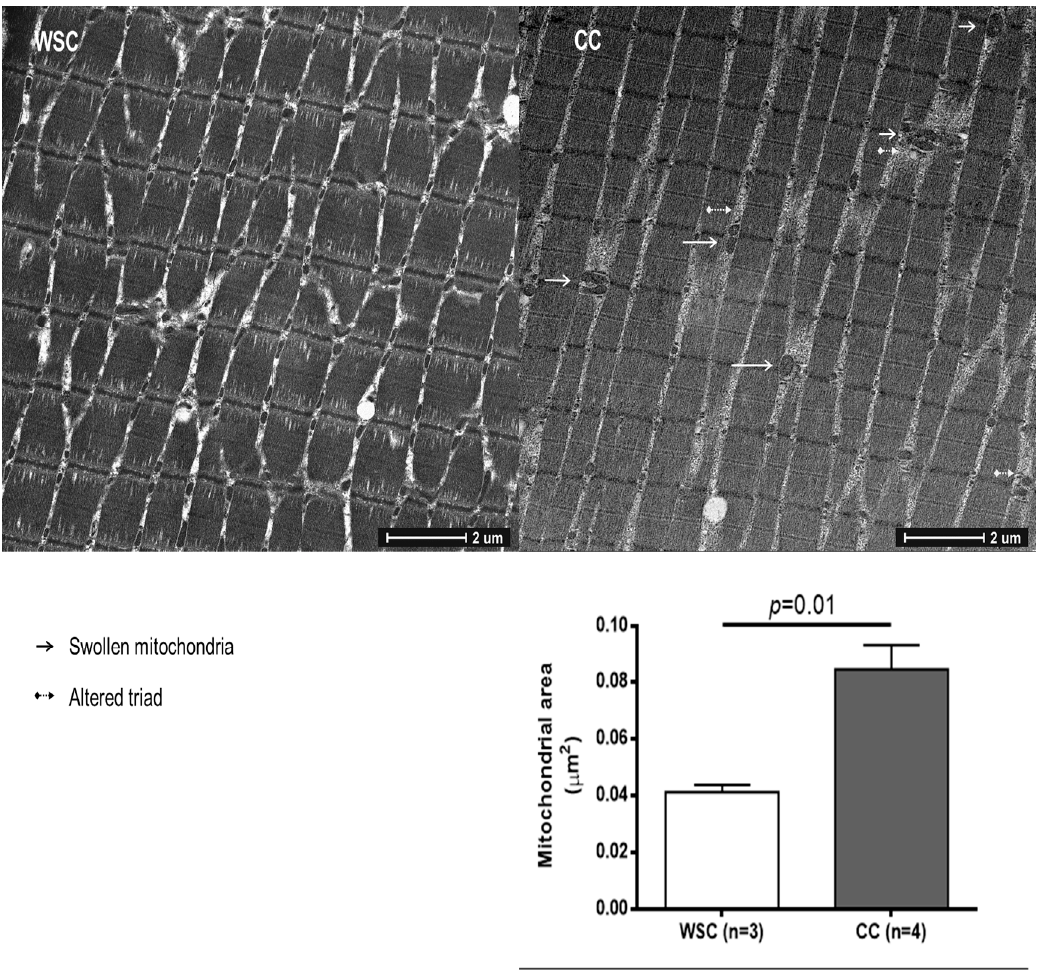
Figure 1. Skeletal muscle photomicrograph and intermyofibrillar mitochondrial area of WSC and CC. Image J software was used to assess mitochondrial area (WSC, n = 3; CC, n = 4). Mitochondrial area was compared using Student’s t test and data are expressed as mean and standard error. WSC— weight-stable cancer patients; CC—cachectic cancer patients. Table 2. Skeletal muscle gene expression of mitochondrial regulation genes in WSC and CC.